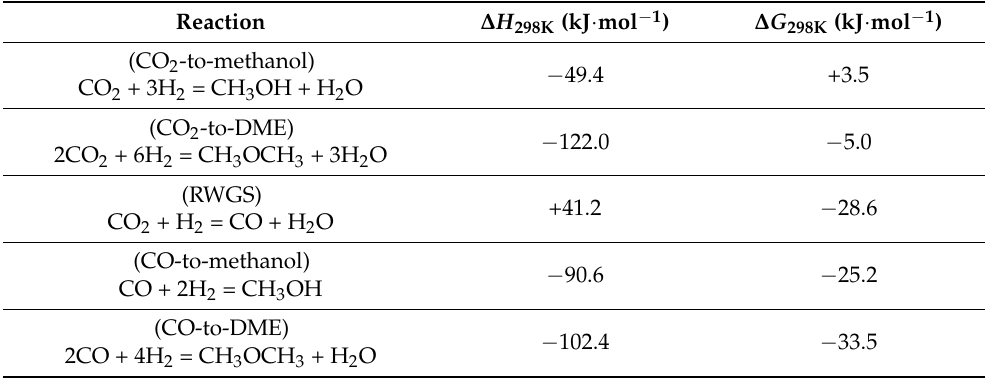
Table 1. Thermodynamic results of reactions involved in the CO 2 hydrogenation to DME. Results are originated from